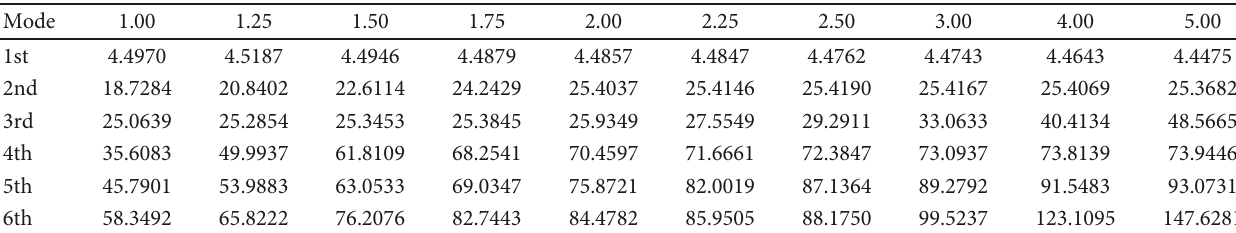
Table 8: Nondimensional frequency parameters for the fi rst six modes of the FG sandwich blade with varying aspect ratio ( h = 20 , n = 2 , = 1/2 , and θ = 30 ° ). h l